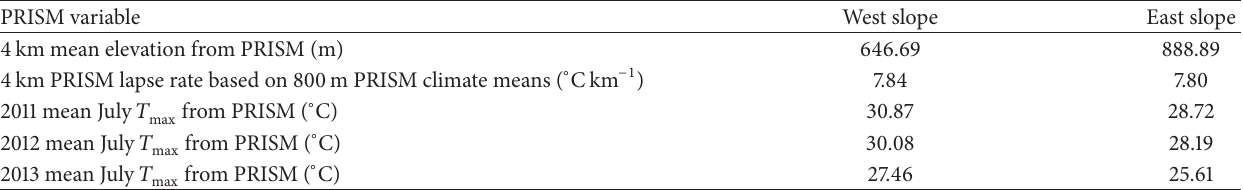
Table 2: 4km PRISM mean elevation, 4km PRISM lapse rate based on 800 m PRISM climate means, and July 2011, 2012, and 2013 4 km PRISM mean July 𝑇 max for the locations at which temperature sensors were deployed along the west slope and east slope of